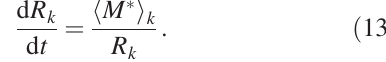
, obtained from A= Λ , where A is the area of the field of view. The quantity R L L